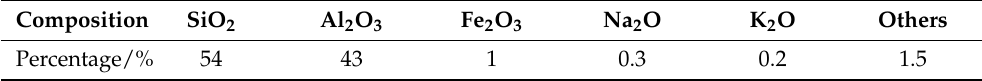
Table 3. The characteristic parameters of metakaolin.